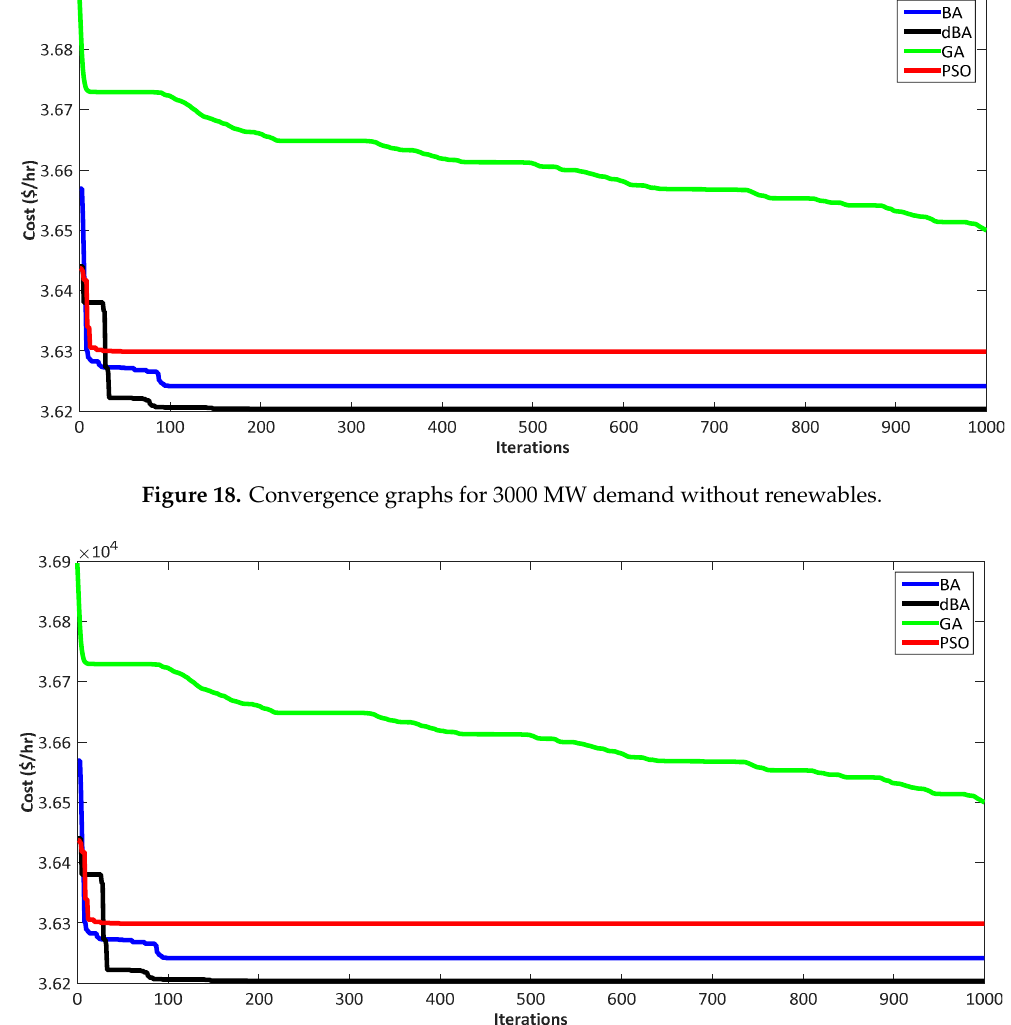
Figure 19. Convergence graphs for 3000 MW demand with renewables.